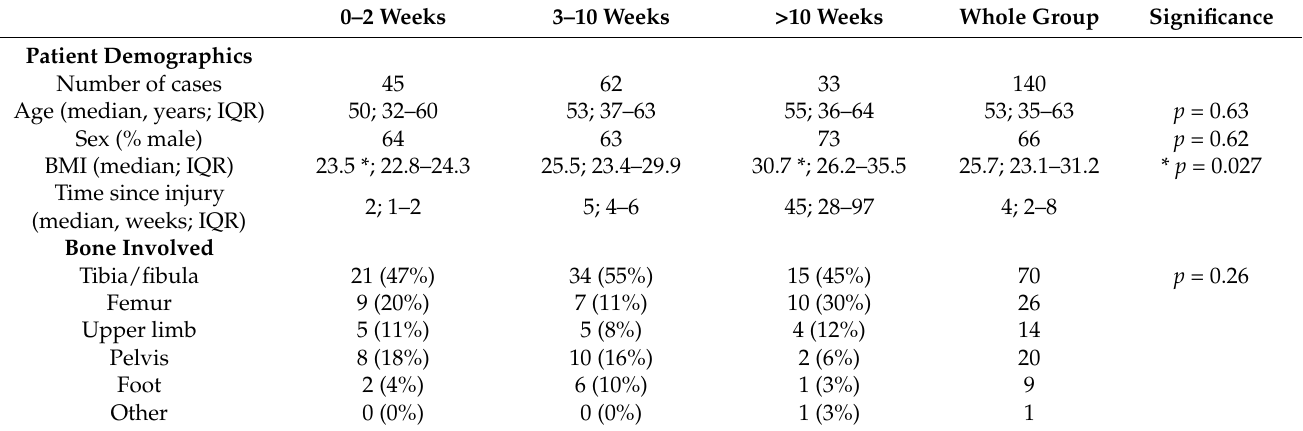
Table 2. Subgroup Analysis of Patients Managed with DAIR by Time Since